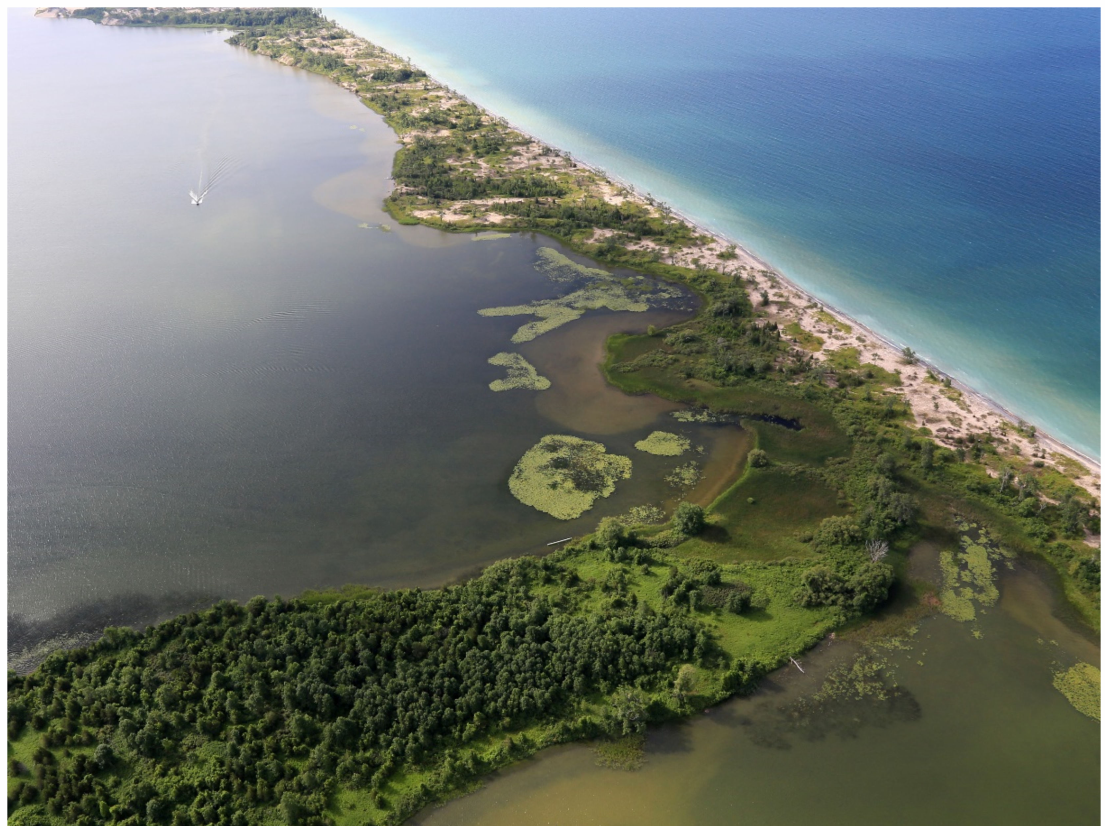
Figure 8. The high water level in West Lake (Aerial image by: John A. Brebner, 2015 © 2016 Friends of Sandbanks